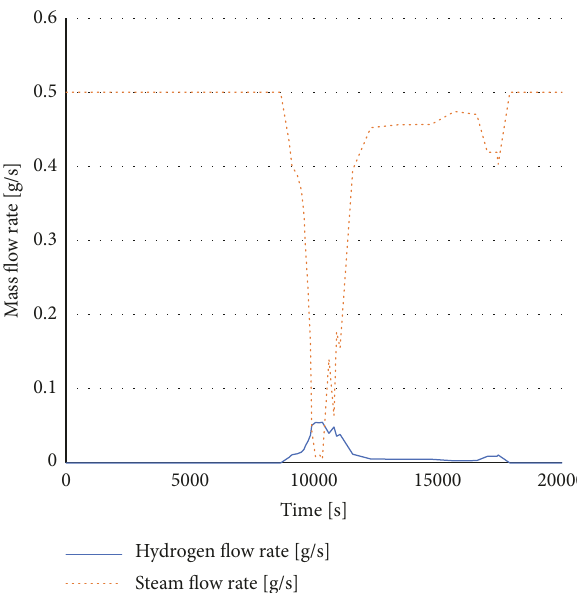
Figure 6: Mass flow rate of hydrogen gas and steam in ART Mod 2.